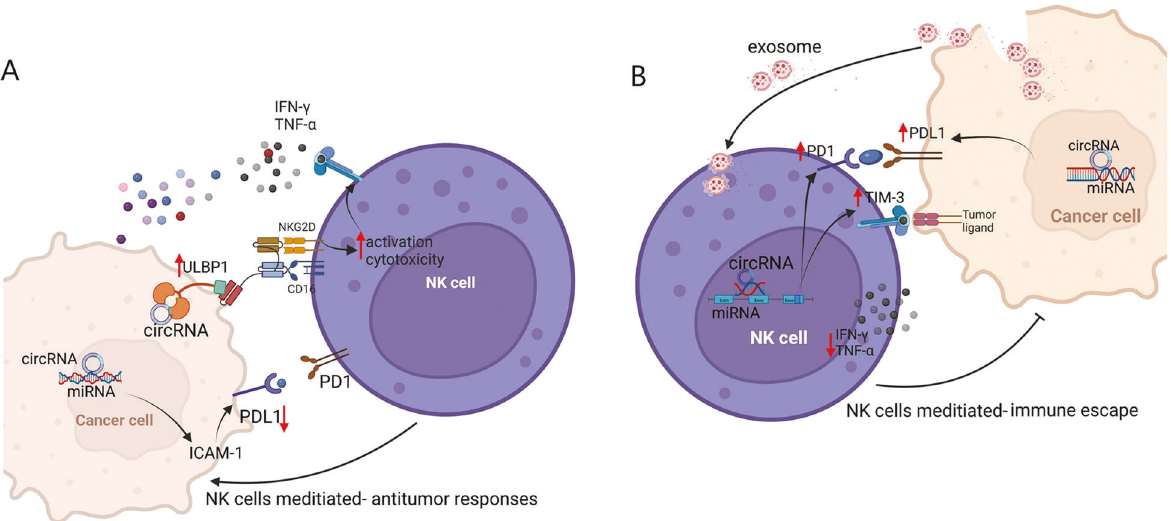
Fig. 3 Circular RNAs have bidirectional modulatory effect on NK cells. A Circular RNAs promoting NK-mediated antitumor responses. B Circular RNAs suppressing NK cell activity to trigger tumor immune escape. ULBP1 human UL 16-binding protein 1, ICAM-1 intercellular cell adhesion molecule-1, NKG2D natural killer group 2 member D, TIM-3 T cell immunoglobulin and mucin domain-containing protein